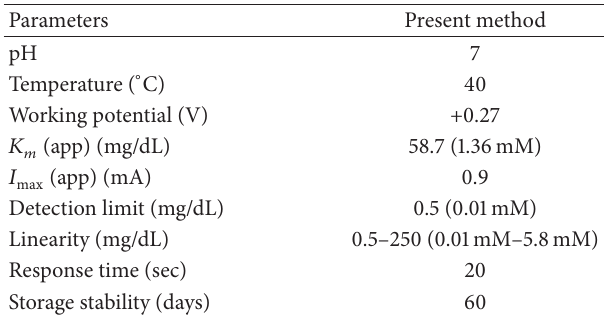
Table 5 outlines the different working parameters of